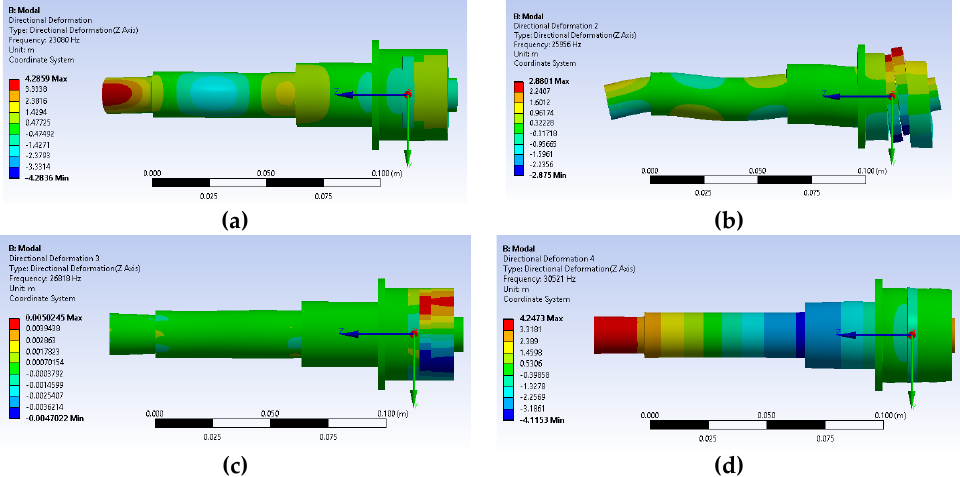
Figure 6. Mode shapes from FE modal analysis for T2; ( a ) Mode 1; ( b ) Mode 2; ( c ) Mode 3; and ( d ) Mode 4.